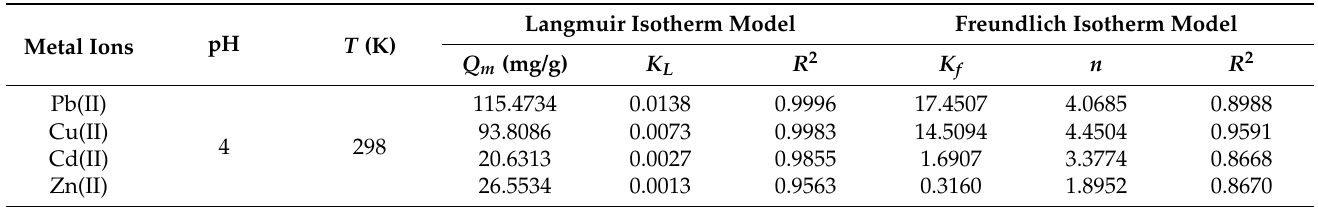
Table 4. Detailed fitting parameters of the adsorption isotherms for the Langmuir and Fre- undlich models.